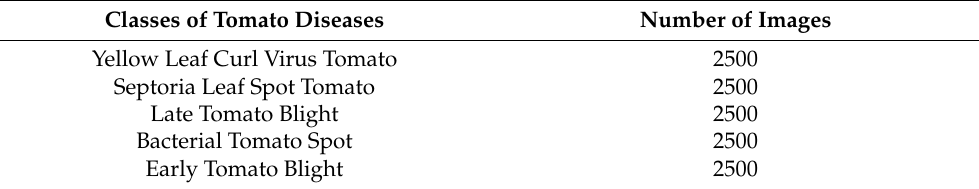
Table 1. Tomato leaf images Dataset